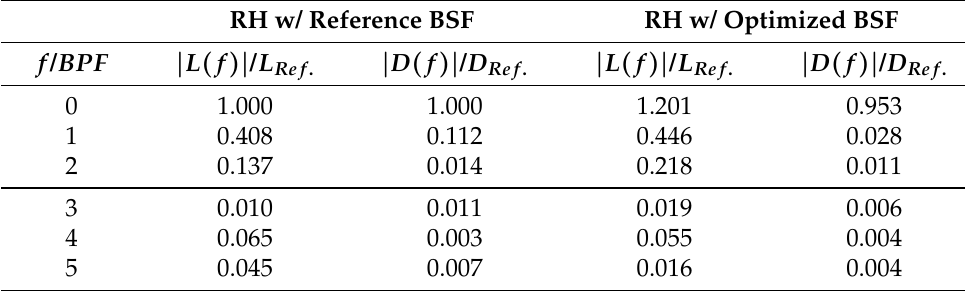
Figure 17. Spectrum of the rotor head lift showing dominant frequencies acting on the rotor head. Table 3. Summary of the FFT analysis regarding rotor head lift and